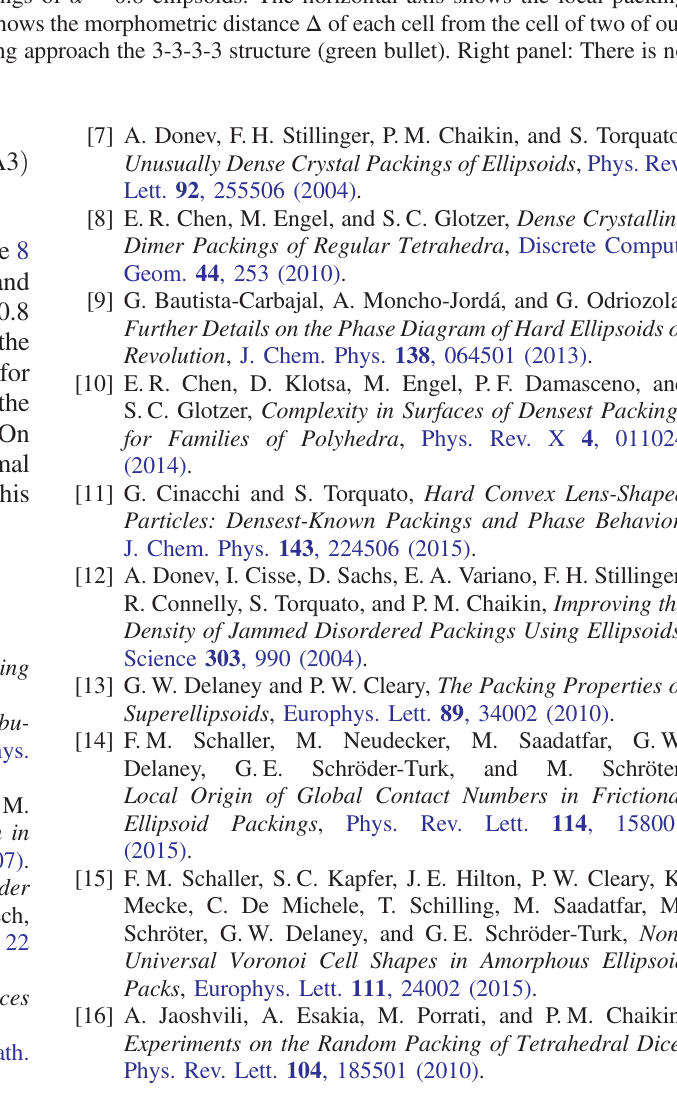
8. Morphometric analysis of the dense random packings of α ¼ 0 . 8 ellipsoids. The horizontal axis shows the local packing fraction of the individual Set Voronoi cells. The vertical axis shows the morphometric distance Δ of each cell from the cell of two of our optimal (densest) structures. Left panel: Clusters in the packing approach the 3-3-3-3 structure (green bullet). Right panel: There is no trend towards the 1-6-6-1 structure (green